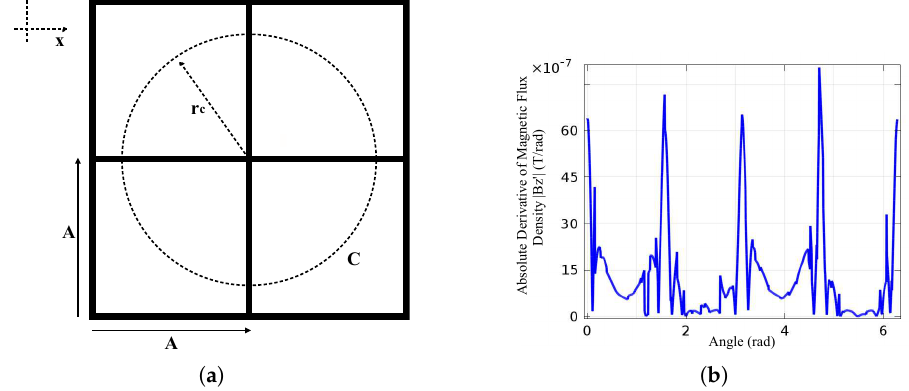
Figure 3. ( a ) 3 × 3 m equally spaced square grounding grid configuration. C is the circle with radius equal to r c on which we take the derivative. ( b ) 1st order derivative of magnetic flux density on C. Peak at 0 rad corresponds to branch position at 0 ◦ , peak at 1.57 rad corresponds to branch position at 90 ◦ , peak at 3.14 rad corresponds to branch position at 180 ◦ and peak at 4.71 rad corresponds to branch position at 270 ◦ . From the location of peaks in Figure 3b, it is determined that grounding grid is lying parallel in the plane of earth as shown in Figure